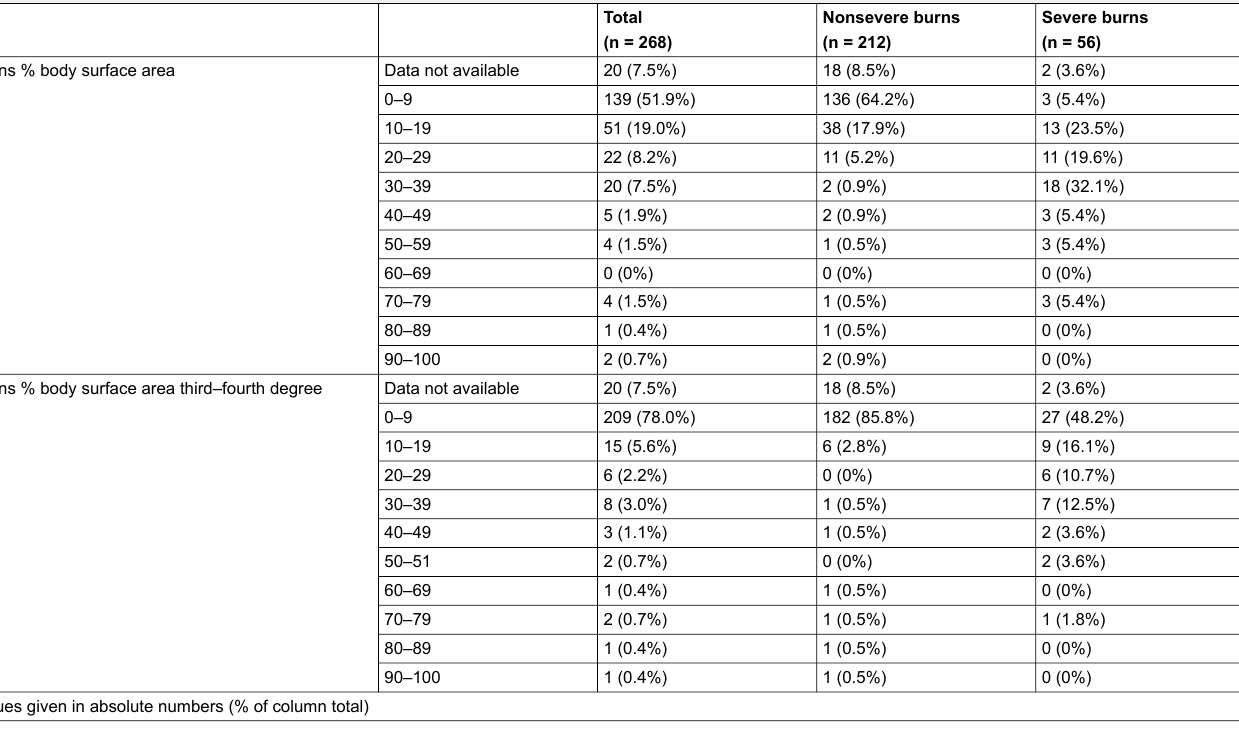
Table 2: Descriptive statistics, severity of burns. Study population: all burns cases discharged from the University Hospital of Zurich (n = 268).